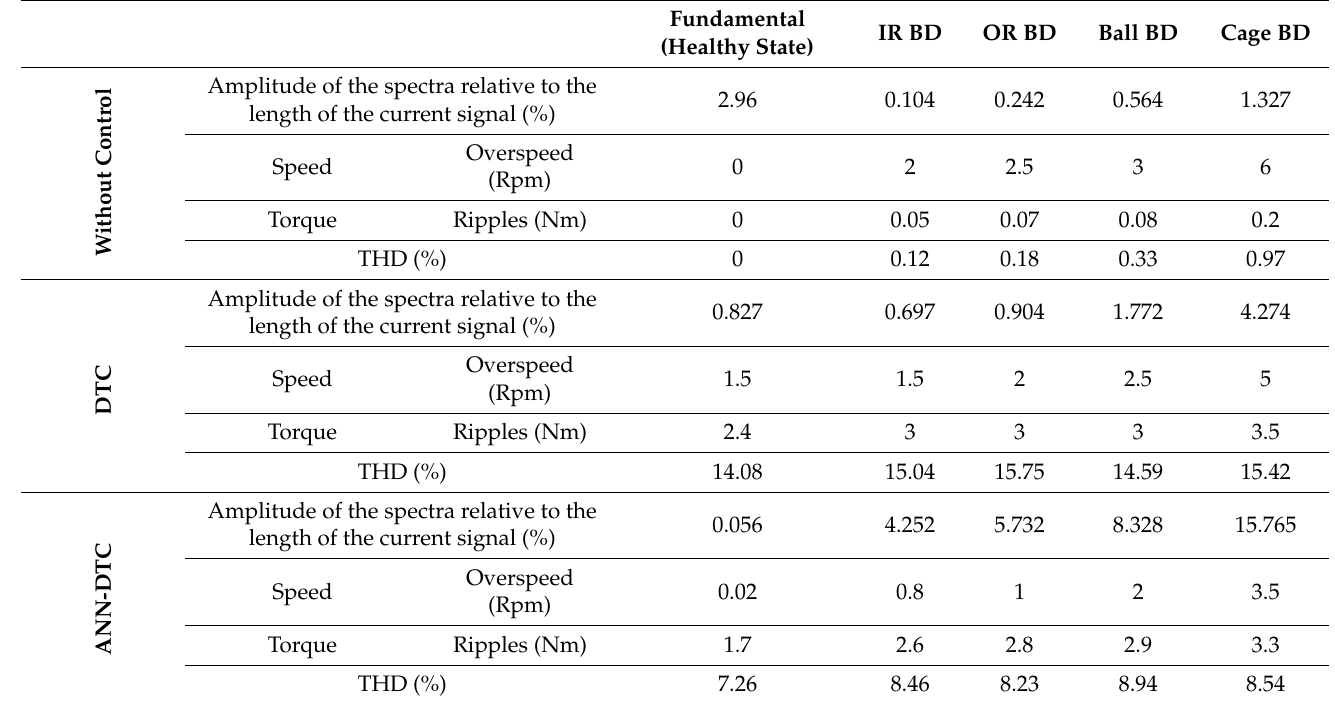
Table 3. Comparison of the amplitudes of the spectra of the BDs. Fundamental IR BD OR BD Ball BD Cage (Healthy State)